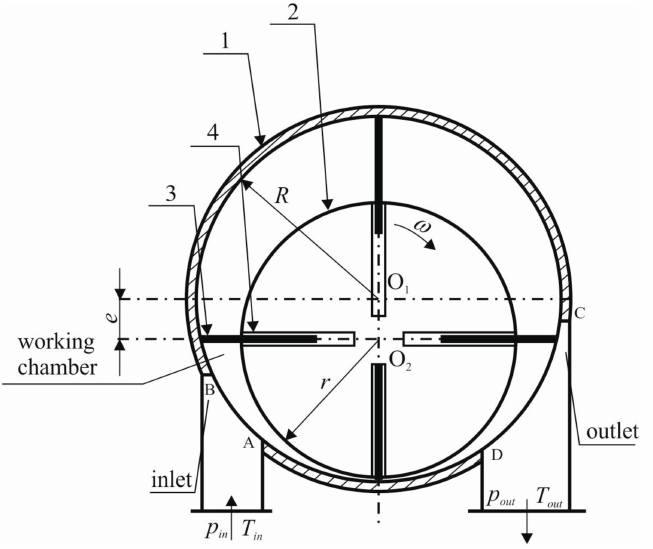
Figure 2. A simplified scheme of the multi-vane expander. 1—cylinder, 2—rotor, 3—vane, 4—vane